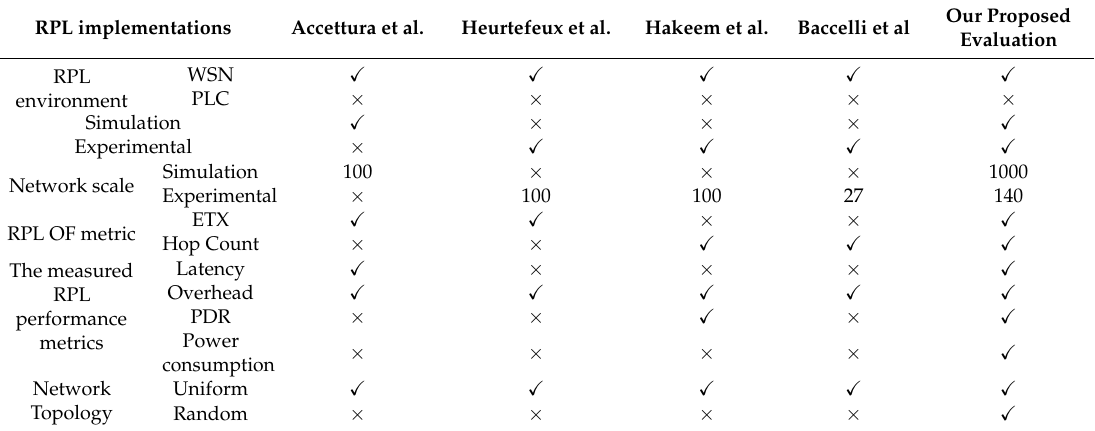
Table 6. Summary of the comparison of different RPL evaluation